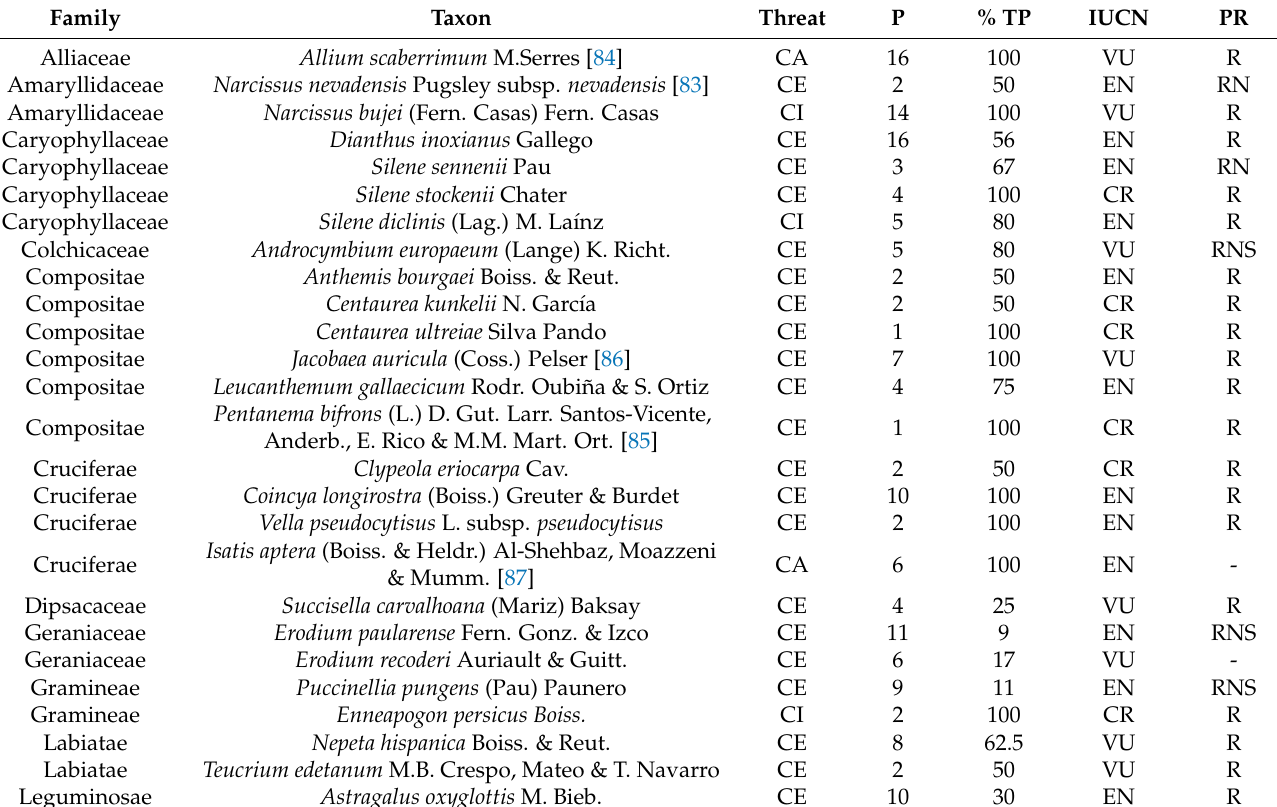
Table 1. Taxa included in this study. The table shows the taxa studied. Family, specie and subspecies are indicated. The reference is indicated when the taxonomic status has been updated according to the AFA and not implying a change in the number of populations or individuals. In addition, the type of threat that mainly affects the taxa is indicated (CE, crop extension; CI, crop intensification; CA, crop abandonment). The following are also indicated are: P, number of populations; % TP, percentage of threatened populations; threat category in IUCN Red List (CR, critically endangered; EN, endangered; VU, vulnerable); PR, degree of legal protection (-, absent; R, regional; N, national; RN, regional-national; S, supranational; RNS, national, regional, and